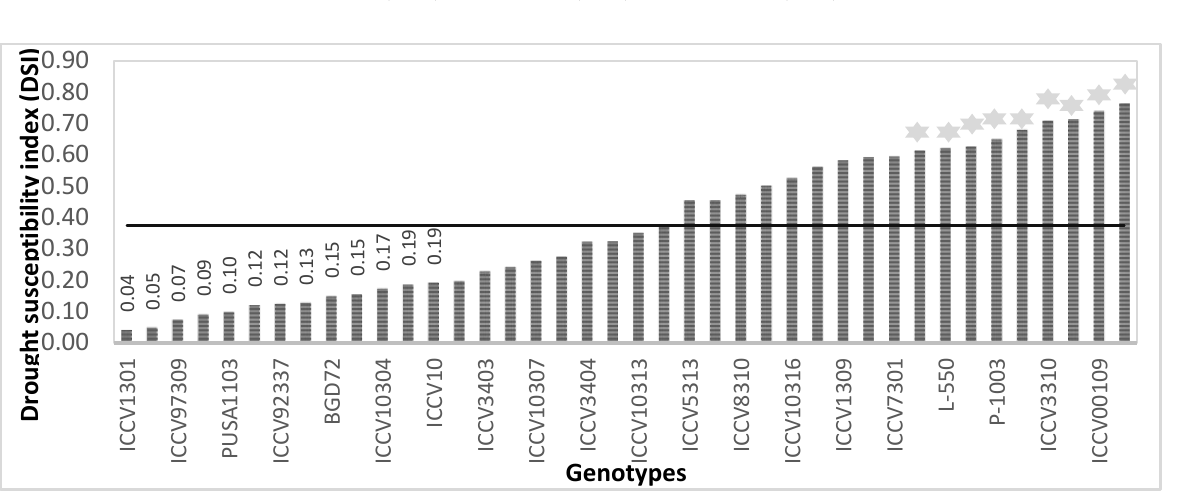
Figure 2. Drought susceptibility index (DSI) values for the forty genotypes. Black line indicates the median value. Lowest DSI values represent the most tolerant genotypes. Stars indicate the highest DSI values (from the left, L-550, ICCV4310, P-1003, ICCV0301, ICCV3310, ICCV95423, ICCV00109, C-235).